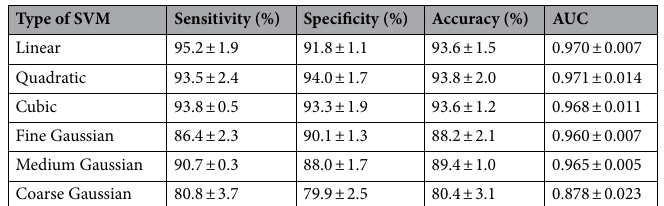
Table 2. Comparison of the classification performance of SVM classifiers for the dataset of the small SDD probe (n = 1363) containing reflectance values from 350 to 1919 nm.